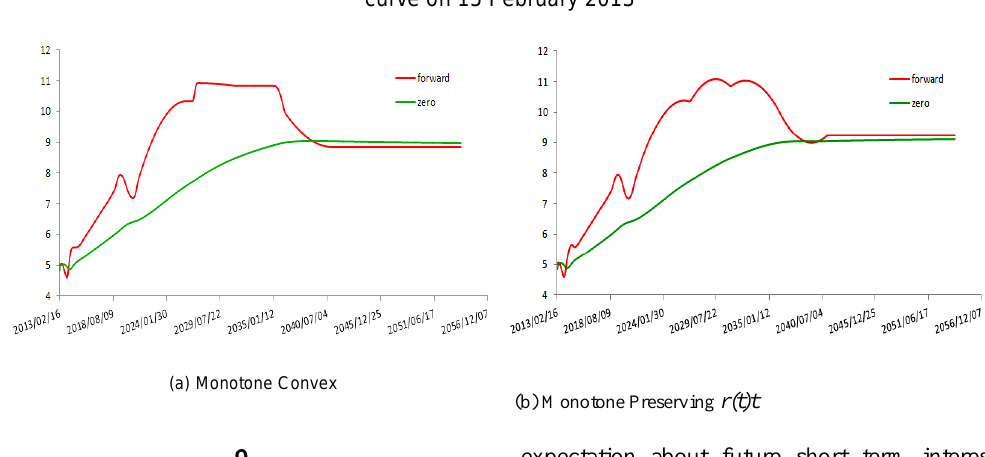
Spot and 90-day forward curves obtained by bootstrapping the South African bond curve on 15 February